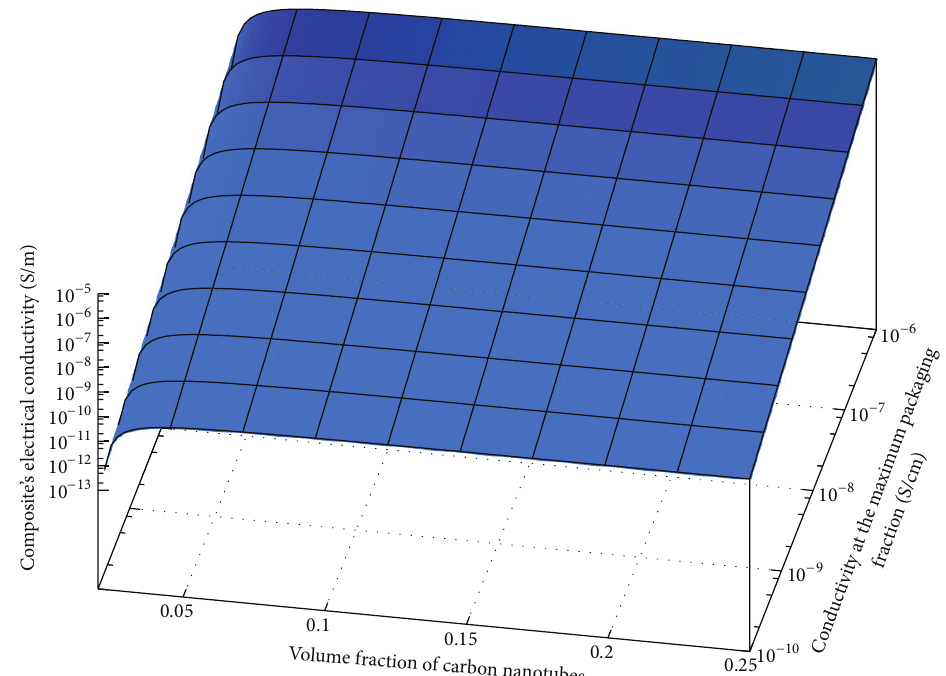
Figure 19: DC electrical conductivity of the nanocomposite at varying both the conductivity at the maximum packaging fraction of the filler and the volume fraction of the filler (Mamunya’s model).